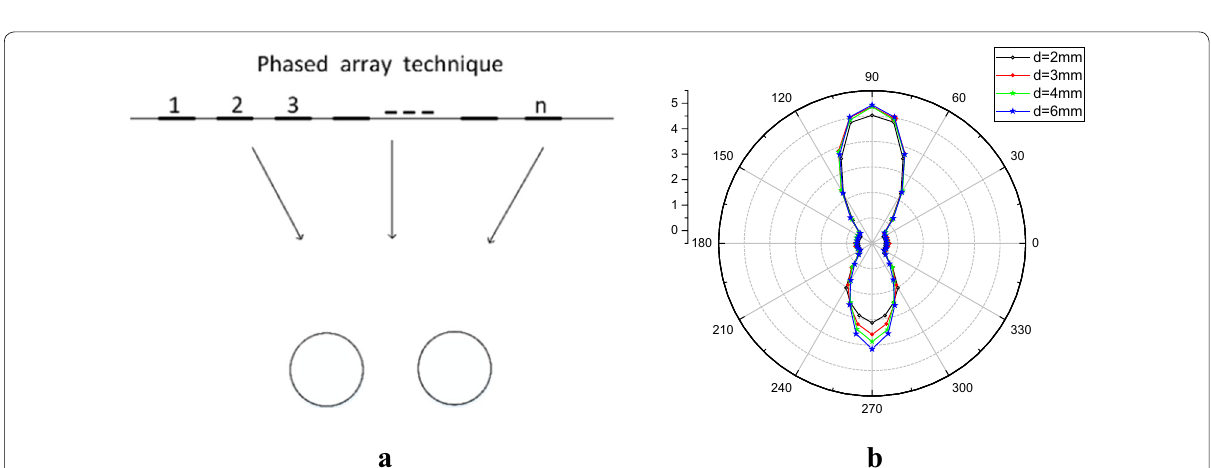
Figure 9 Location and directivity of sound wave with phased array technique versus different distances for cylinders ( f = 850 kHz , and ka = 1.8